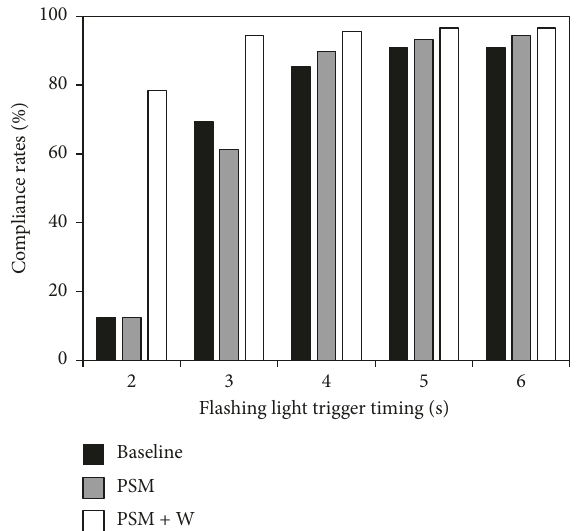
Figure 7: Proportions of drivers who compliant after the flashing light triggered.